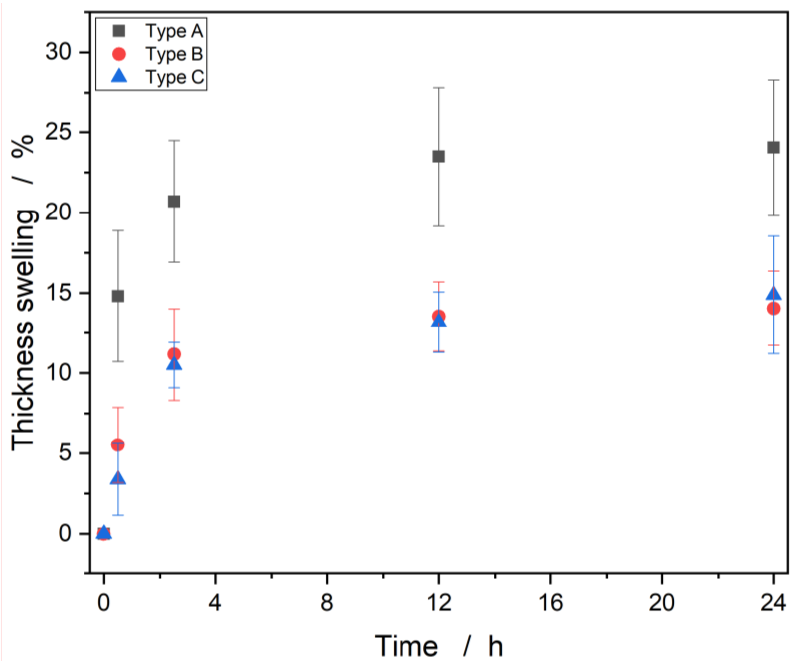
Figure 6. Thickness swelling as a function of time.